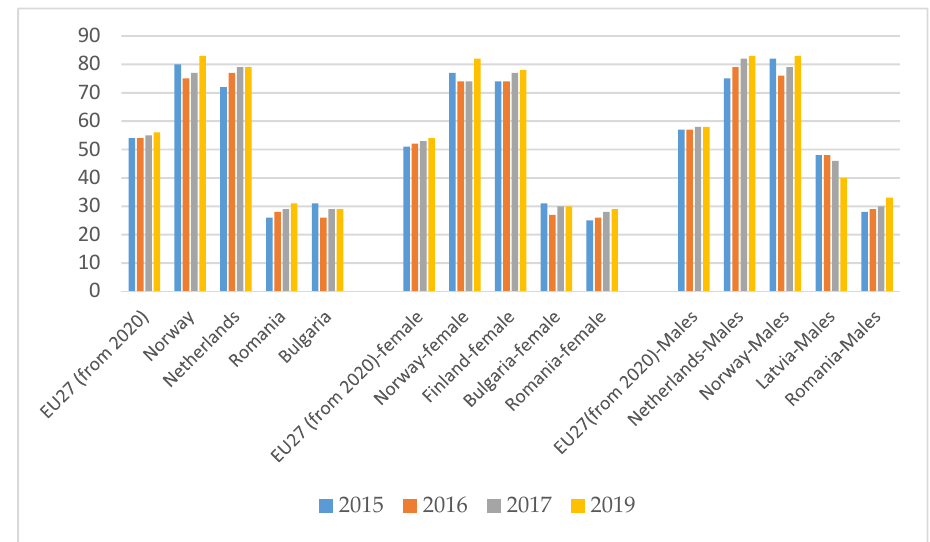
Figure 7. Individuals who have basic or above basic overall digital skills by gender as a percentage. Source: Authors projection using Eurostat database. Data extracted on 12 September 2021 online data code: TEPSR_SP410.